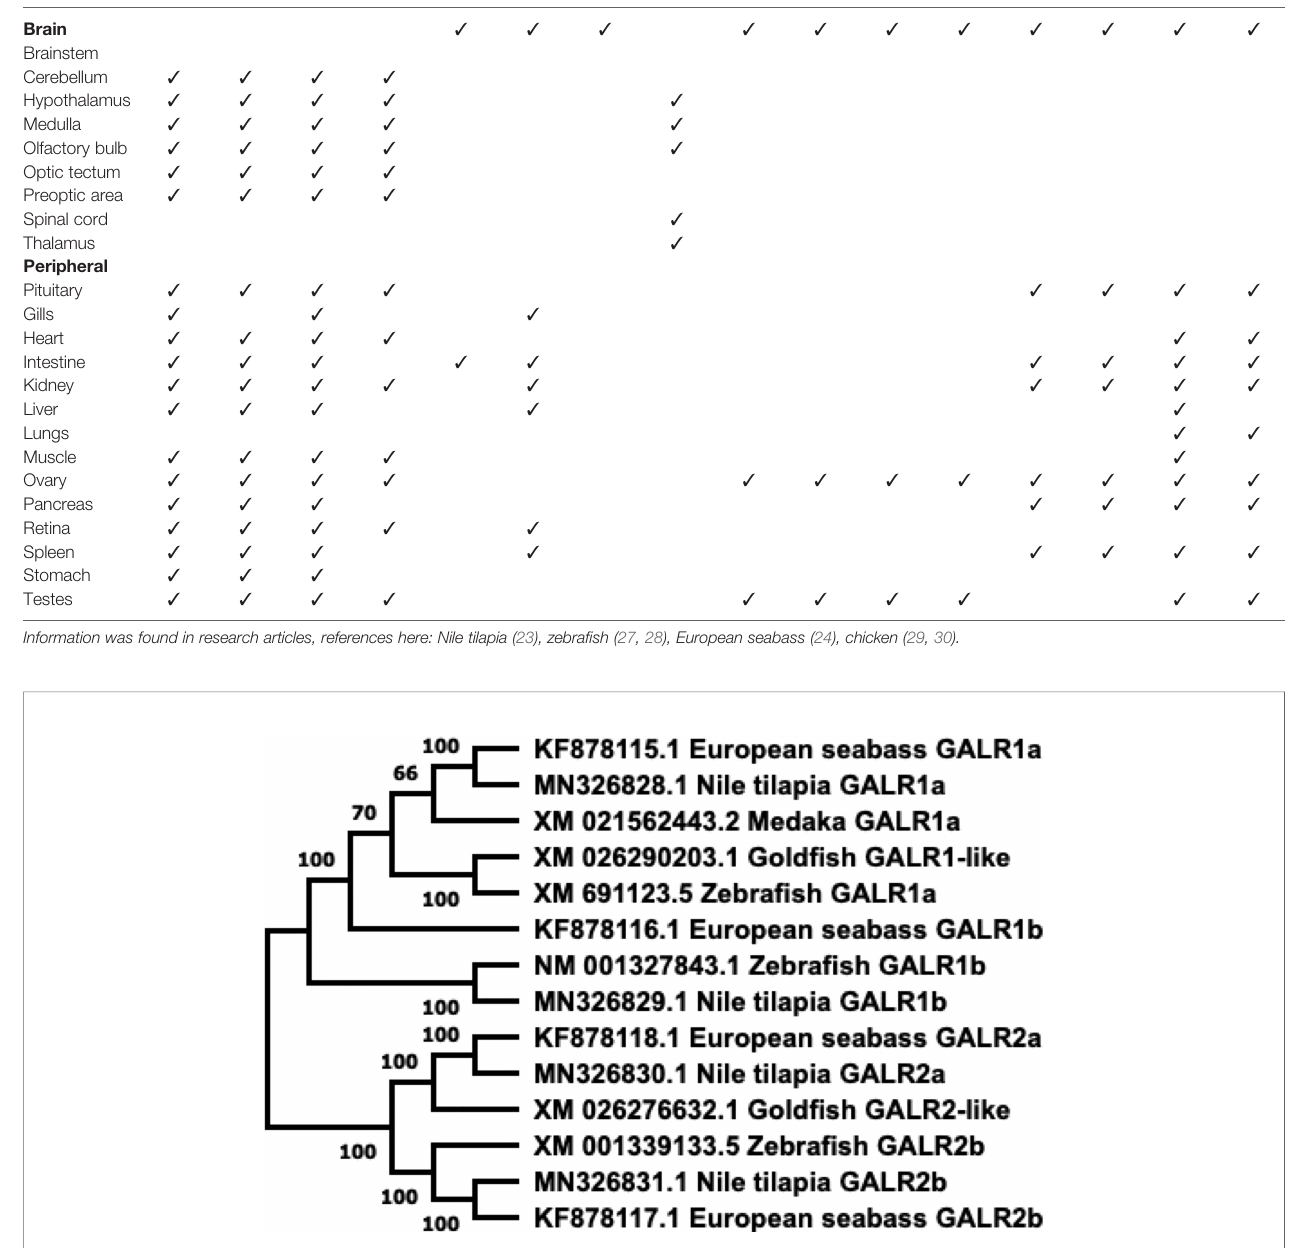
FIGURE 4 | Phylogenetic tree of GALRs present in fi sh. Sequences obtained from GenBank. Phylogenetic construction was done in MEGA X, using the Neighbor- Joining method. The percentage of the sequences clustered together is shown on the branches, out of 1000 boots. GALR1 and GALR2 form distinct